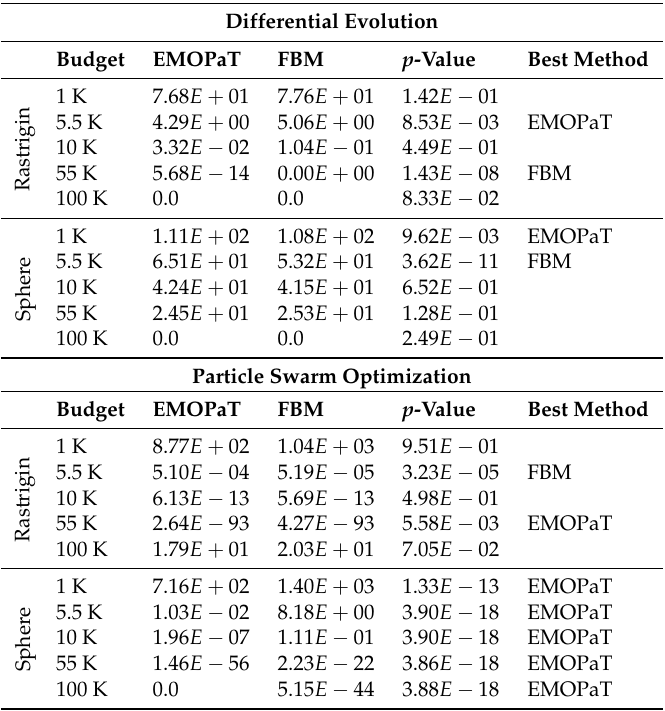
Table 6. Comparison between the performance of the configurations found by EMOPaT and the Flexible-Budget method